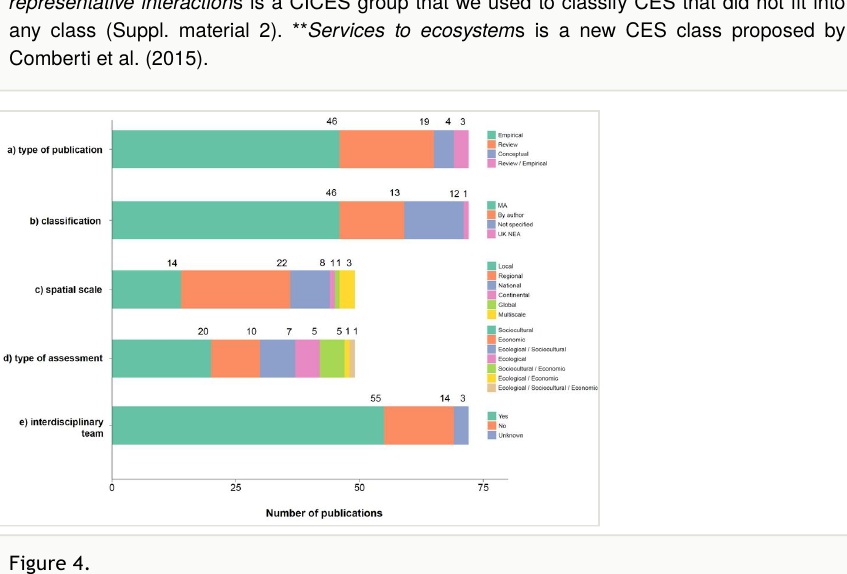
Overview of literature review data variables. Data variables include: (a) type of publication (n=72); (b) classi fi cation (n=72); (c) spatial scale of empirical studies (n=49); (d) type of assessment of empirical studies (n=49); (e) interdisciplinary team